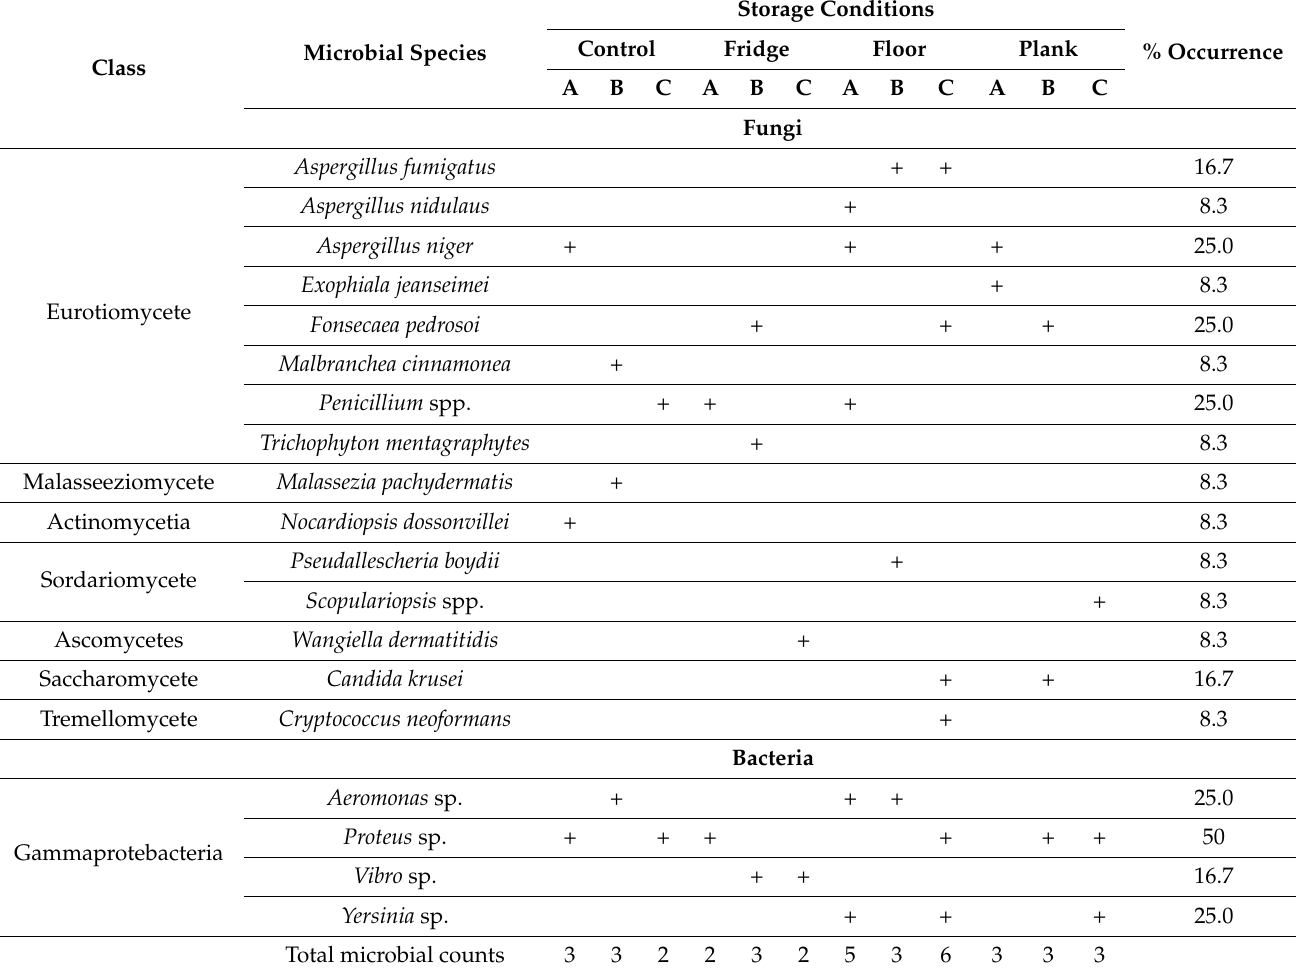
Table 4. The occurrence of fungal and bacterial species identified from three brands of sachet water samples subjected to different storage